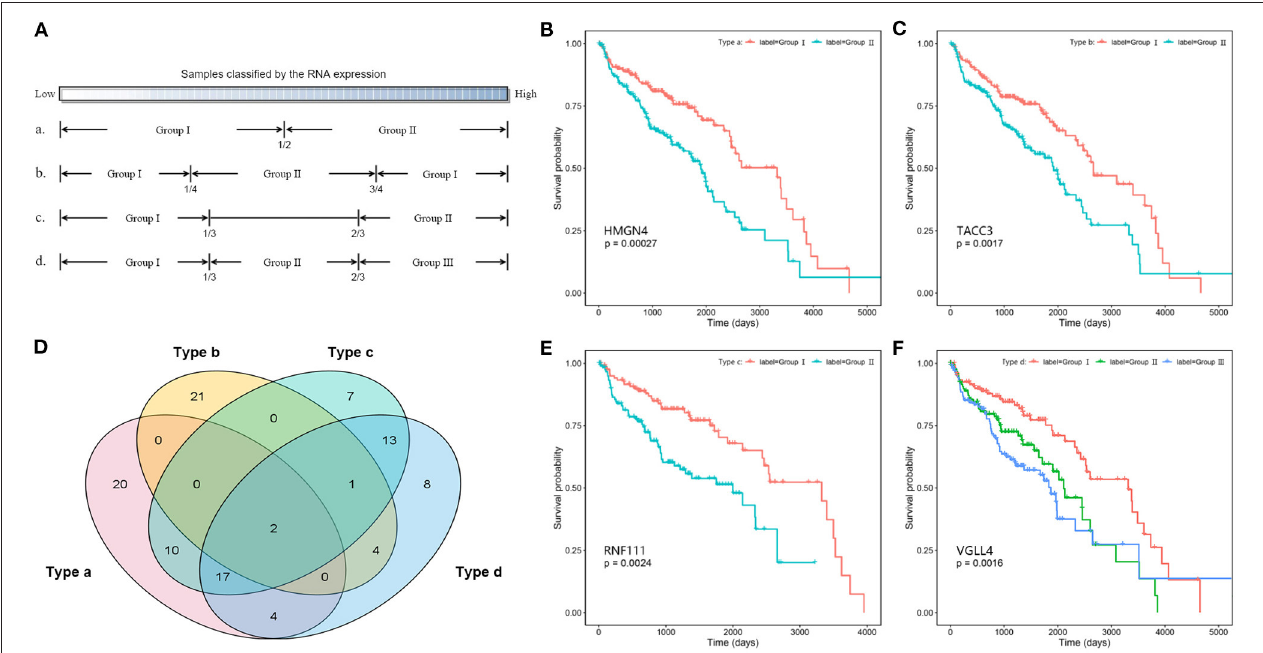
FIGURE 6 | Survival analysis of competing triplets. (A) Four grouping modes. (B) The Kaplan–Meier curve of HMGN4 with mode a. (C) The Kaplan–Meier curve of TACC3 with mode b. (D) The Venn diagram of survival associated genes with four grouping modes. (E) The Kaplan–Meier curve of RNF111 with mode c. (F) The Kaplan–Meier curve of VGLL4 with mode